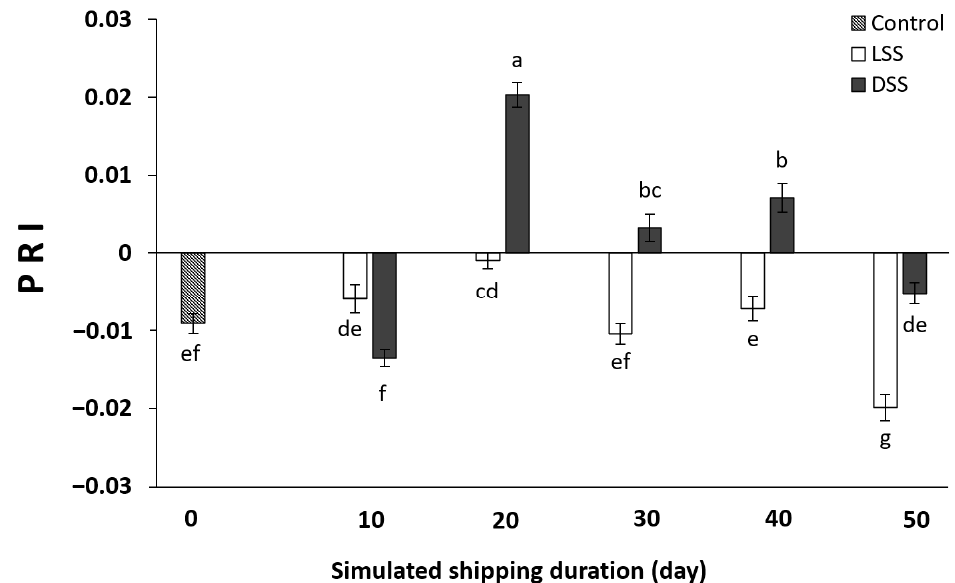
Figure 5. Photochemical reflectance index (PRI) at the end of each simulated shipping as influenced by simulated shipping duration in Phalaenopsis Sogo Yukidian ‘V3’. Within-graph means followed by the same letter are not significantly different according to Duncan’s multiple range test at p ≤ 0.05.